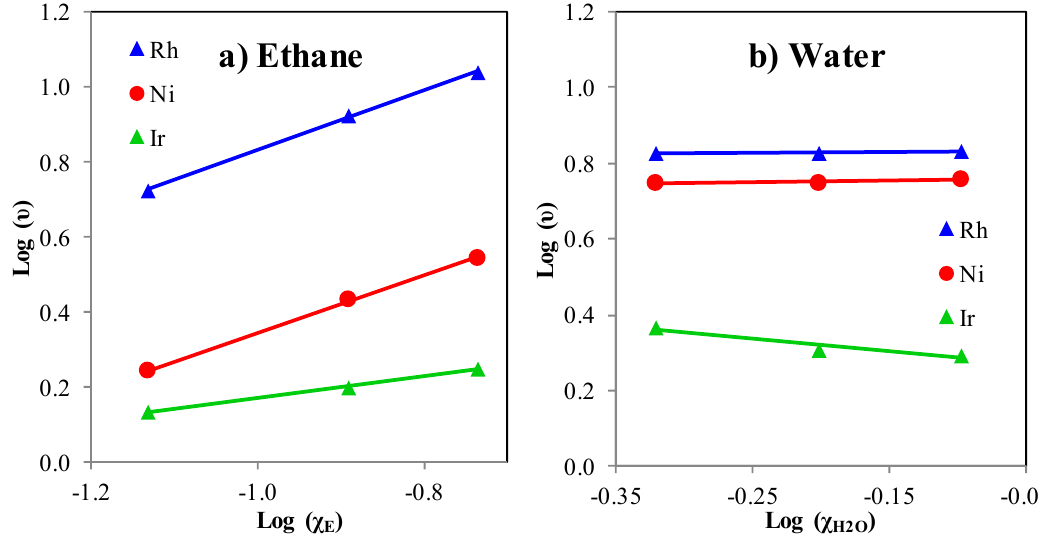
Figure 6. Logarithmic plot for catalytic rate vs. partial pressure of ( a ) ethane and ( b ) water. Table 3. Kinetic parameters calculated for ethane steam reforming reaction at 600 °C.